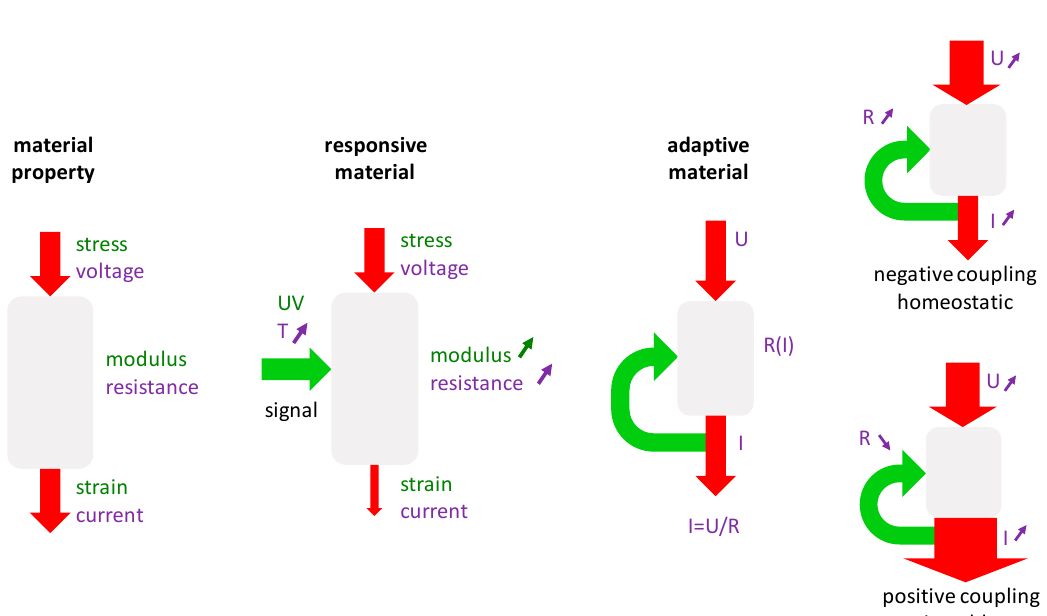
Figure 1. Comparison between different material behaviors: in the simplest case a material property like resistance or modulus is characterized by a fixed value ( left ); in responsive materials ( middle ) the property can be influenced by an external stimulation; in adaptive materials the stimulation is created internally by feeding back a signal related to the material’s output ( right ).